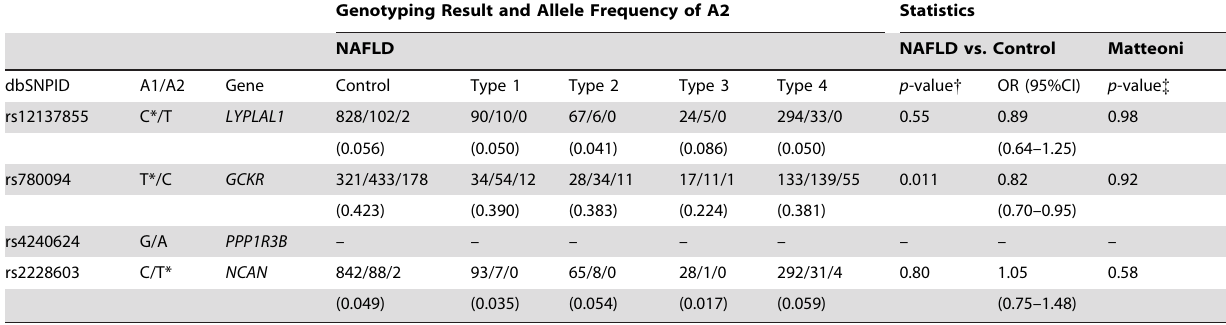
Table 4. Replication study of previously reported